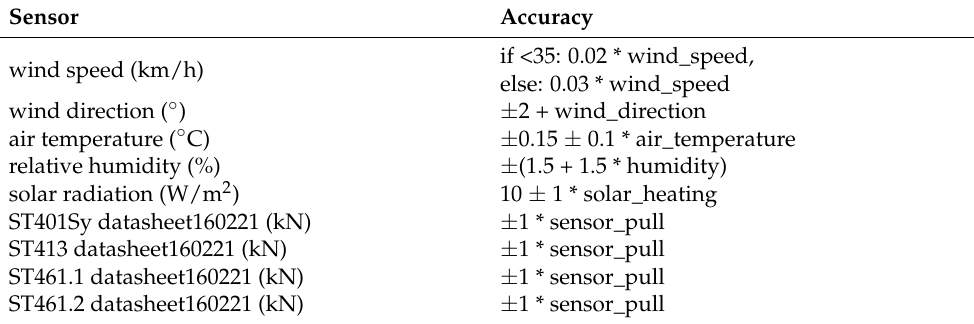
Table 2. Sensors’